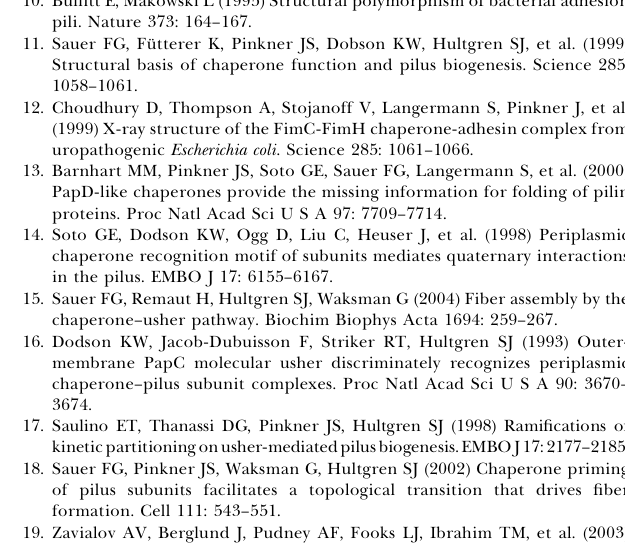
Figure S1. Sequence Alignment of Pap Subunit Ntes